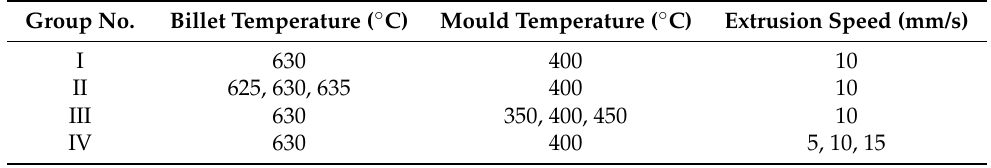
Table 2. Process parameters for the SSTEF in the simulation. Group